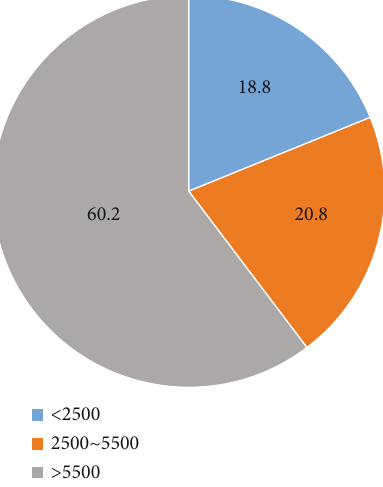
Figure 2: The ratio of family income and care.